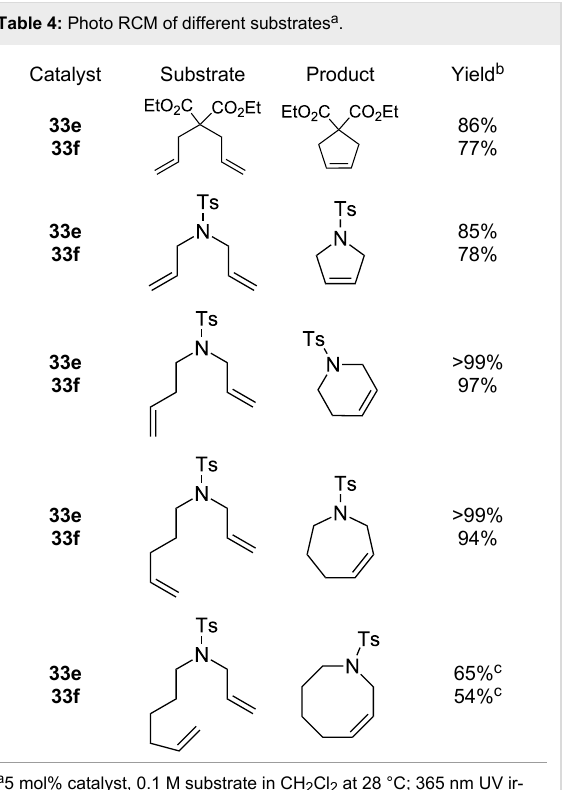
Table 4: Photo RCM of different substrates a .